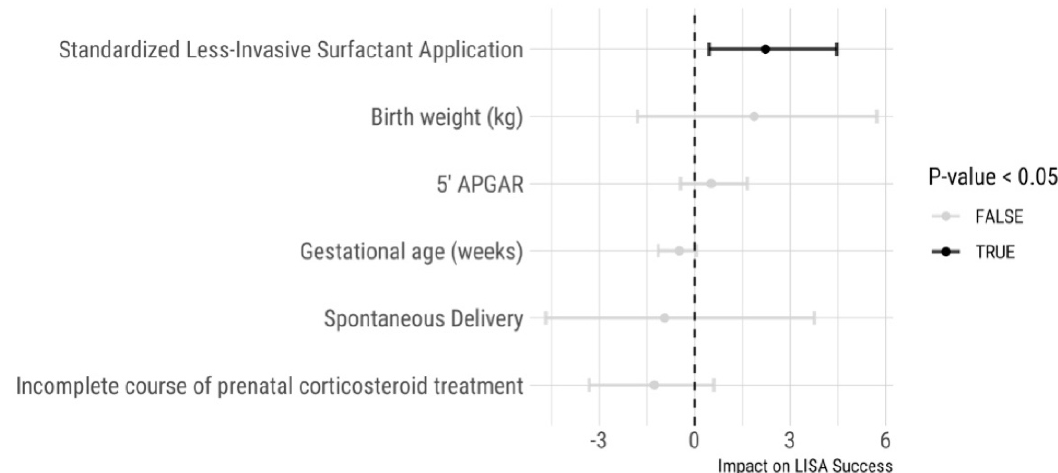
Figure 2. Logistic multivariable regression model to predict less invasive surfactant application success. Only the time point after the intervention was a significant predictor of successful less invasive surfactant application.